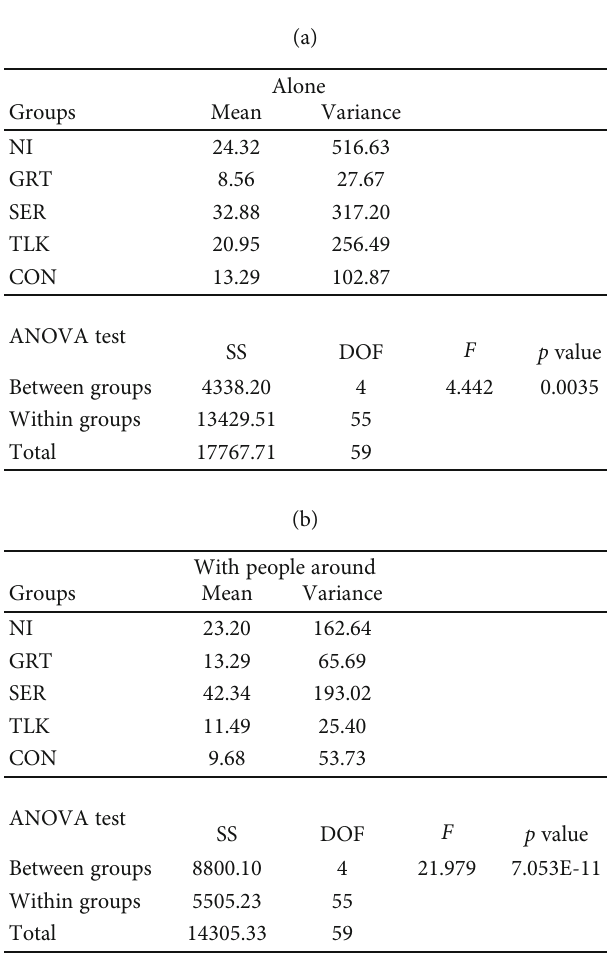
Table 5: ANOVA test for the comparison of the frequencies of each conversational preference during each task.